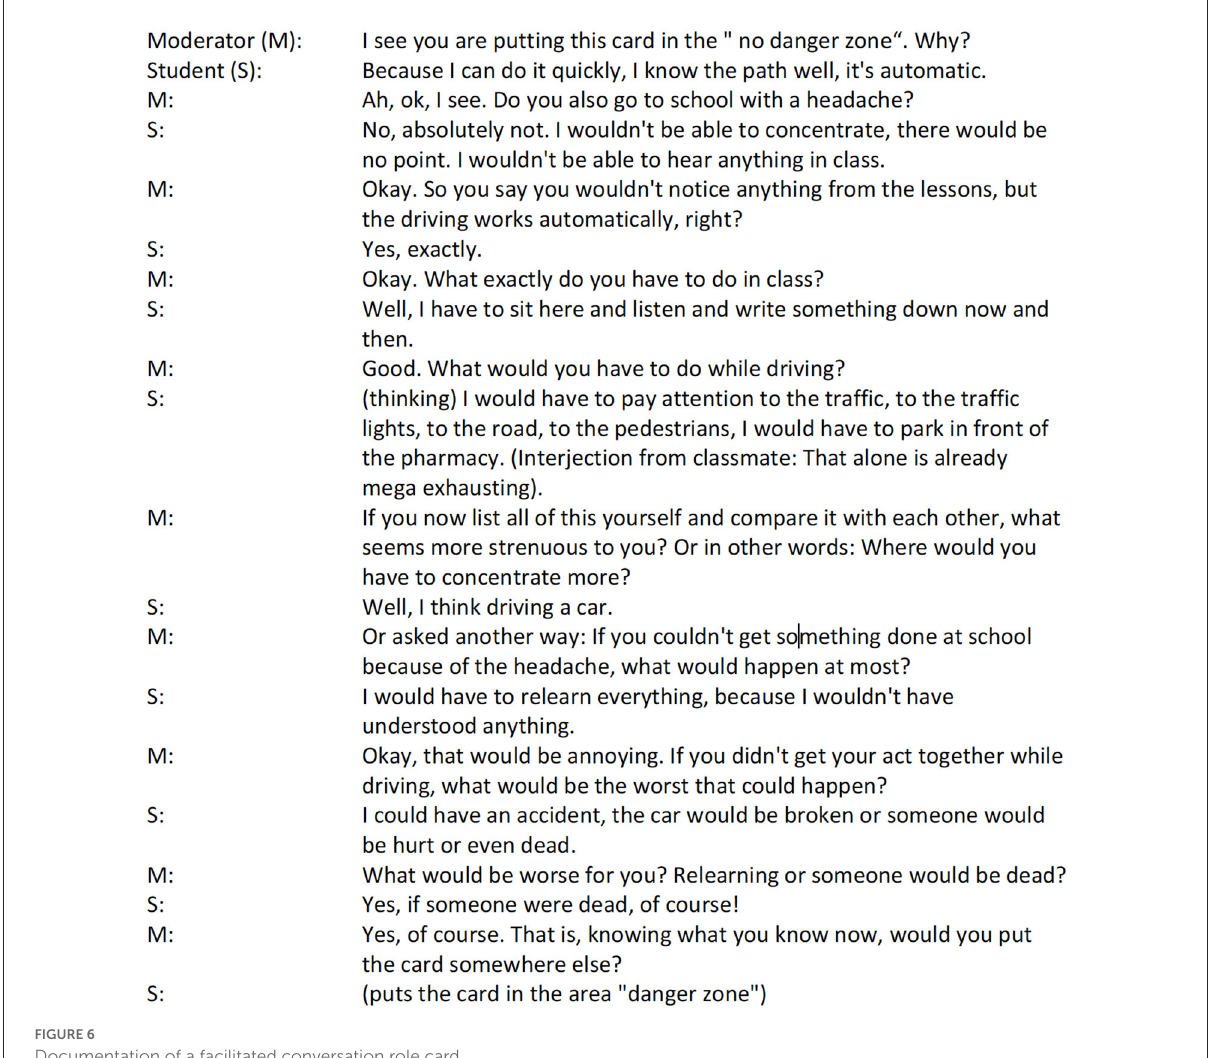
At the end of the discussion, no card was in the “Risk” range anymore. According to the post-test evaluation (post-test